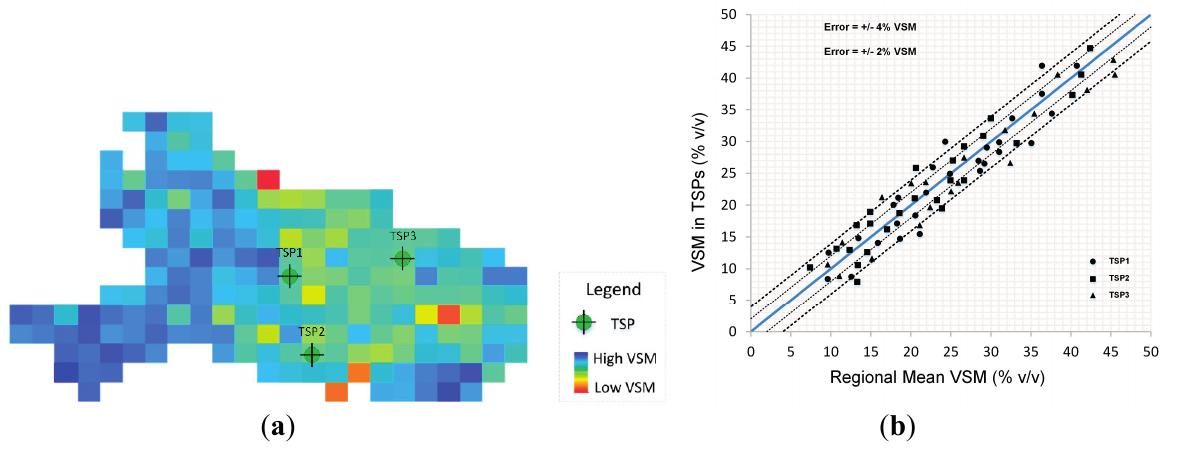
Figure 7. ( a ) The locations of the selected three TSPs in the region. ( b ) Comparison of the regional mean soil moisture versus the soil moisture values of the three